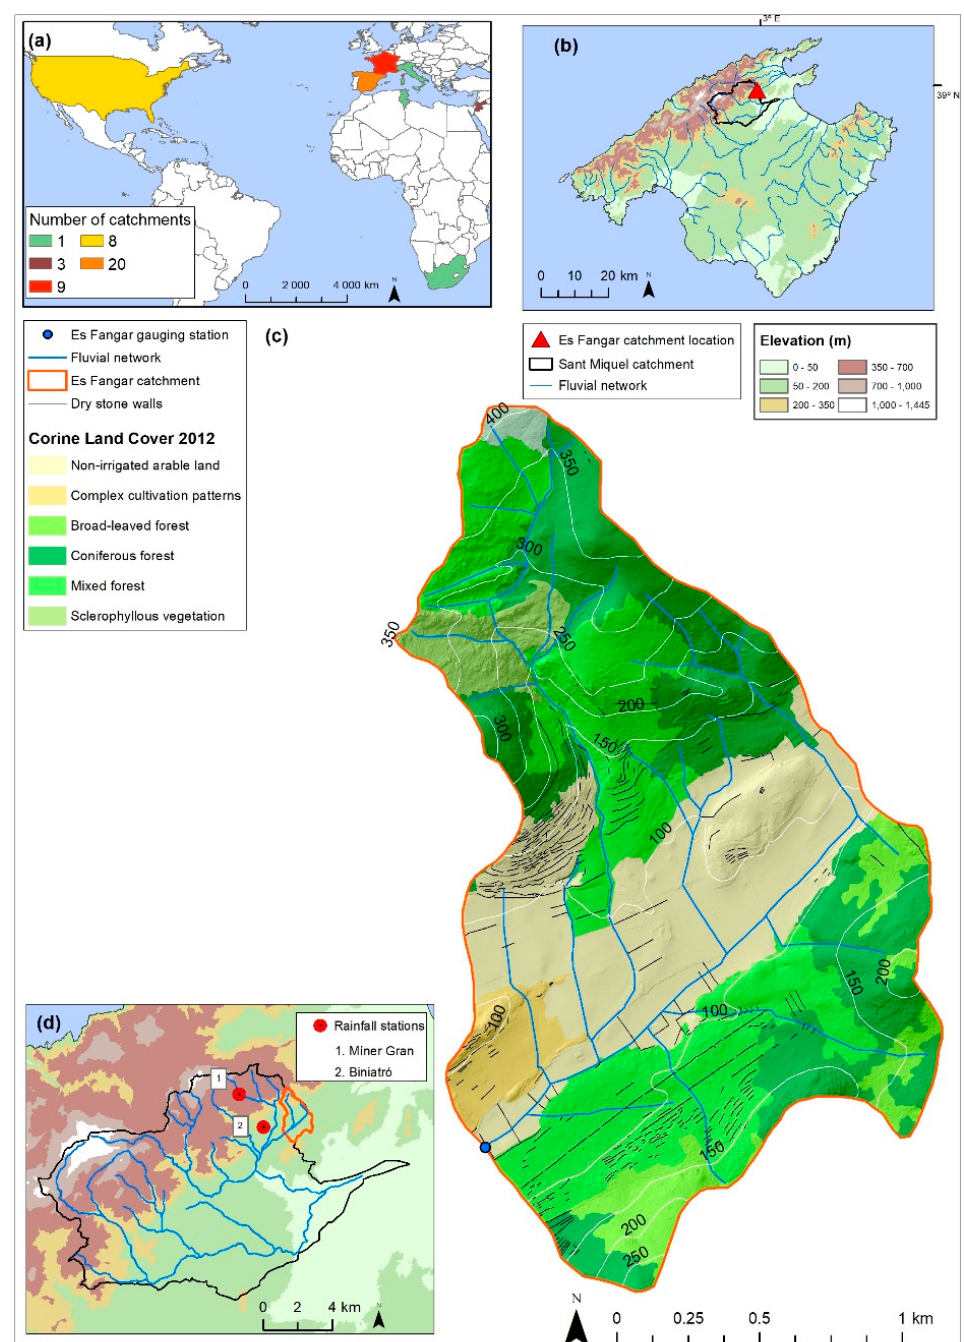
Figure 1. ( a ) Map of the small Mediterranean-climate catchments selected to assess the rainfall-runoff relationship at the annual and event scale. ( b ) Map of Mallorca Island, showing the location of the Sant Miquel River and Es Fangar Creek catchments. ( c ) Map of the Es Fangar Creek catchment, showing the different land-uses, the stream network and the gauging station. ( d ) Map of the Sant Miquel River catchment with the location of rainfall stations used in this study.